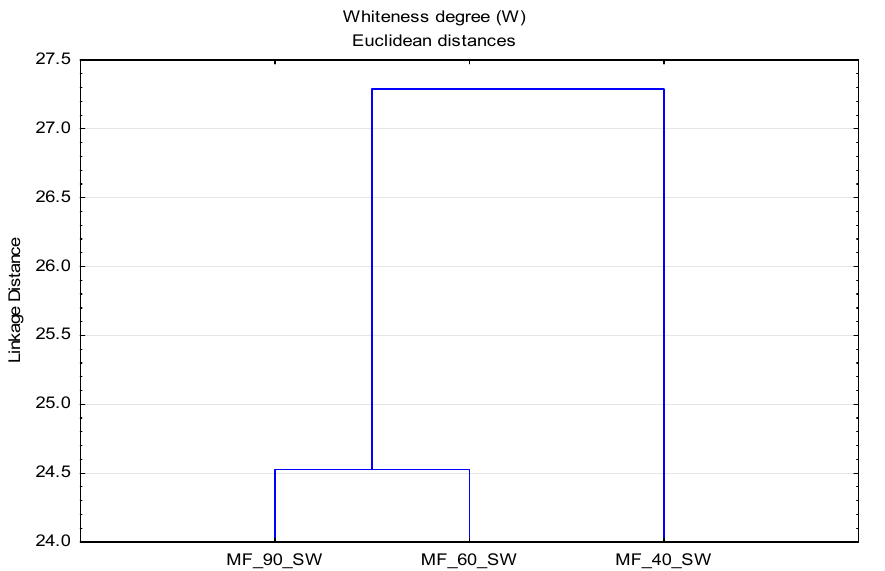
Figure 11. Dendrogram of the whiteness degree (W) of surface modified fabrics as a function of temperature (T) and soft water (SW).